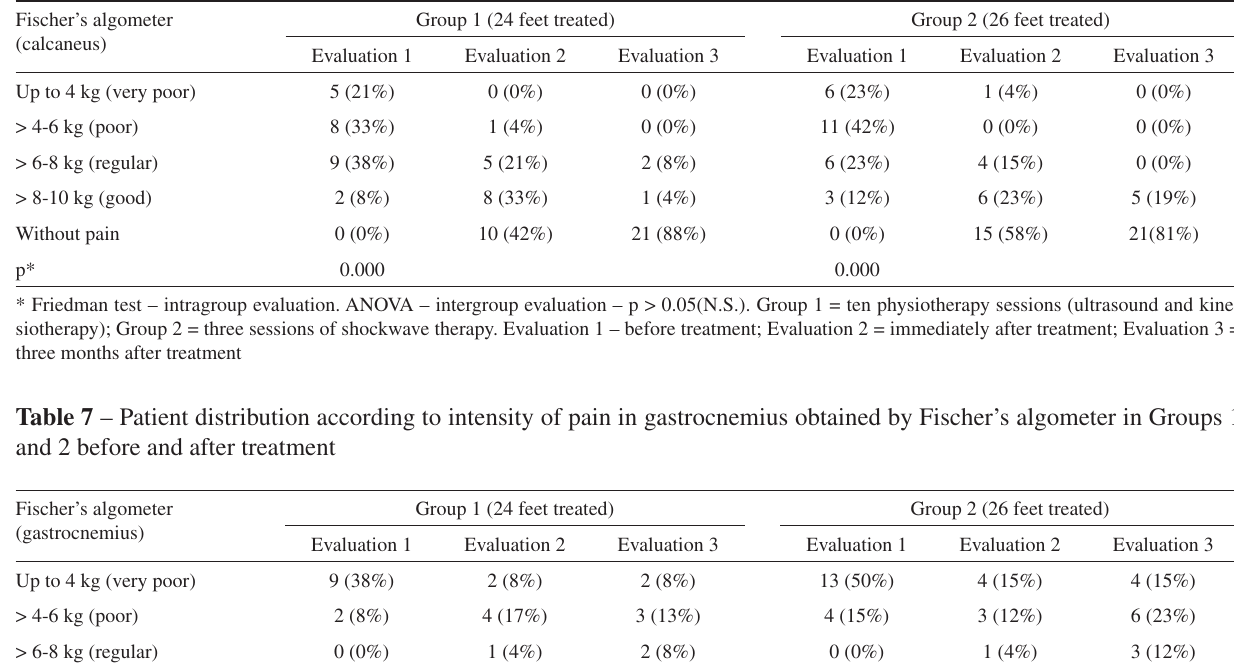
Table 6 – Patient distribution according to intensity of pain in calcaneus obtained by Fischer’s algometer in Group 1 (con-